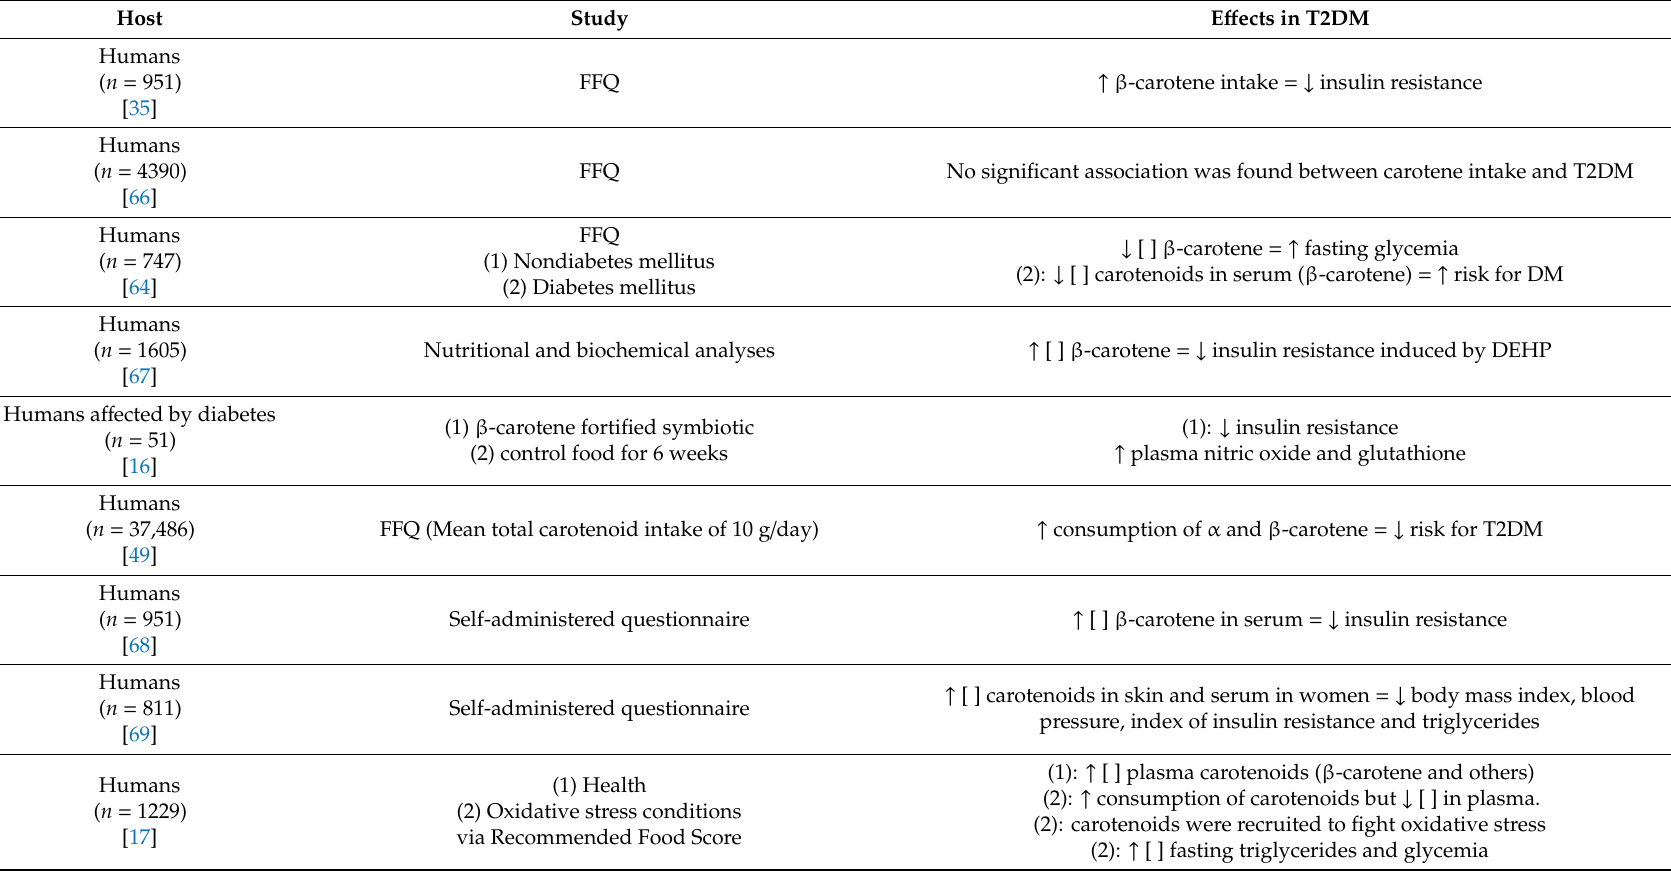
Table 2. E ff ects of carotenoids on T2DM parameters in